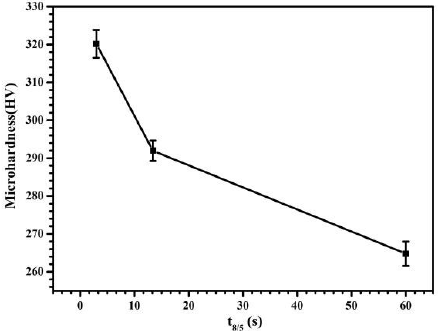
Figure 8. Micro-hardness of the simulated ICCGHAZs with different cooling rates.